Question: How would you classify this visualization?
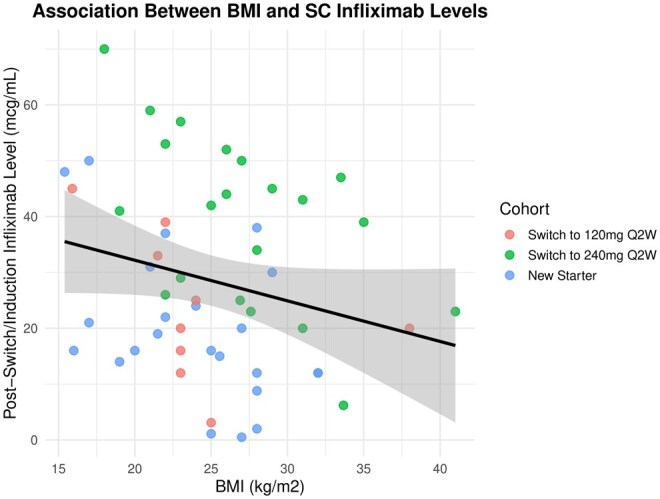
Answer: scatter